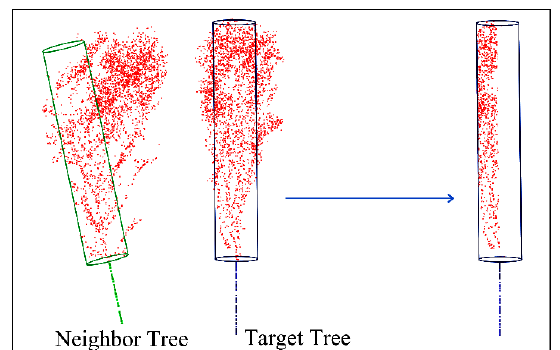
Figure 7. The DSITs definition for couple tree